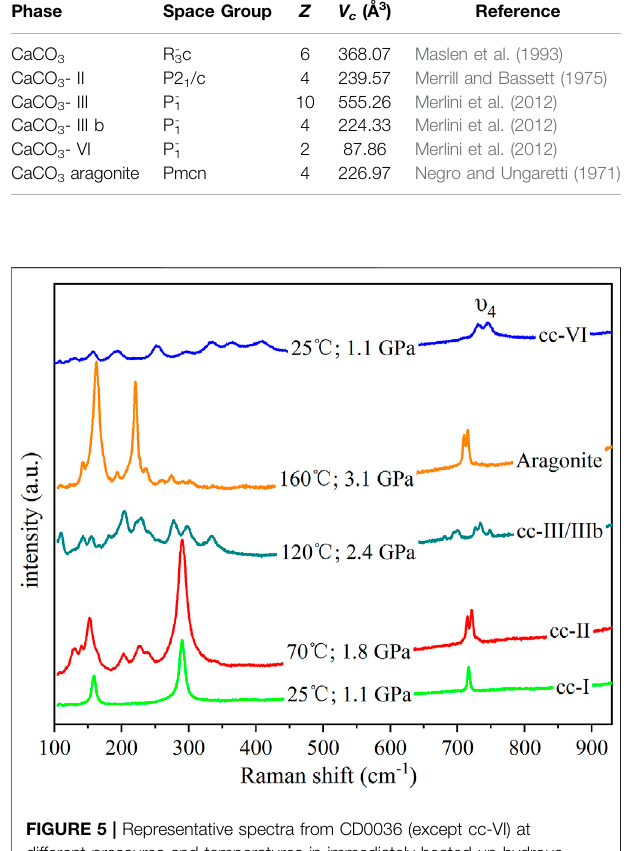
FIGURE 5 | Representative spectra from CD0036 (except cc-VI) at different pressures and temperatures in immediately heated up hydrous experiments. Cc-VI is from